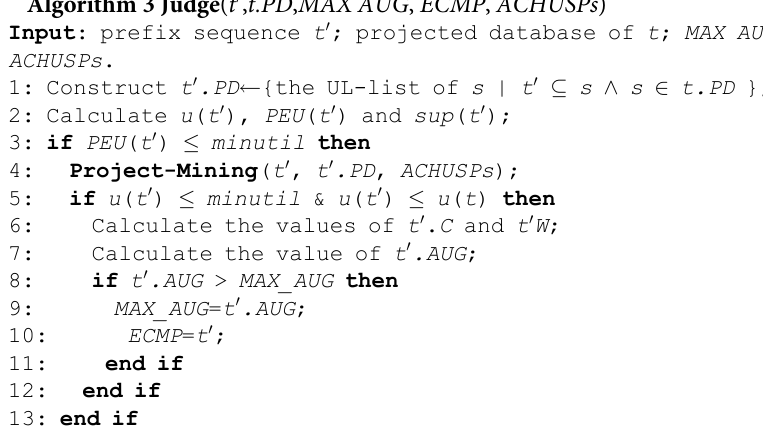
Algorithm 3 Judge ( t 0 , t.PD , MAX AUG , ECMP , ACHUSPs